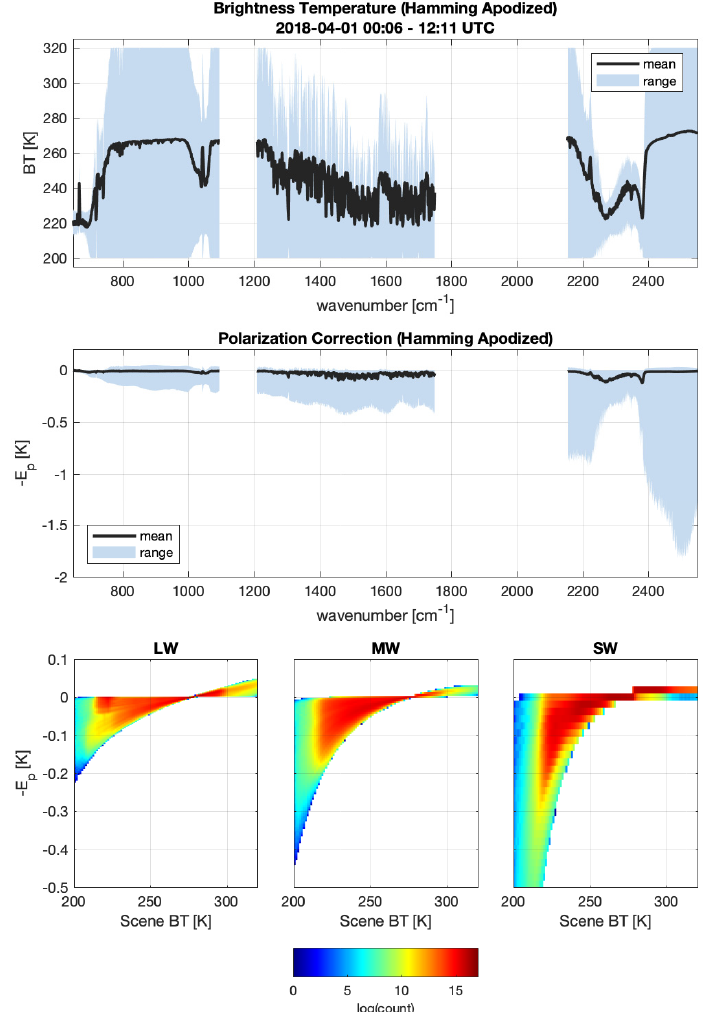
Figure 21. NOAA-20 polarization correction as a function of scene brightness temperature for scene brightness temperatures between 200 K and 320 K for 12 h of data on 1 April 2018 (00:06–12:11 UTC). The spectrally resolved scene brightness temperatures (mean and range) are shown in the top panel and the corresponding polarization corrections (mean and range) are provided in the middle panel. The distribution of polarization correction versus scene brightness temperature for the longwave ( left ), midwave ( center ), and shortwave ( right ) are shown in the bottom panel.